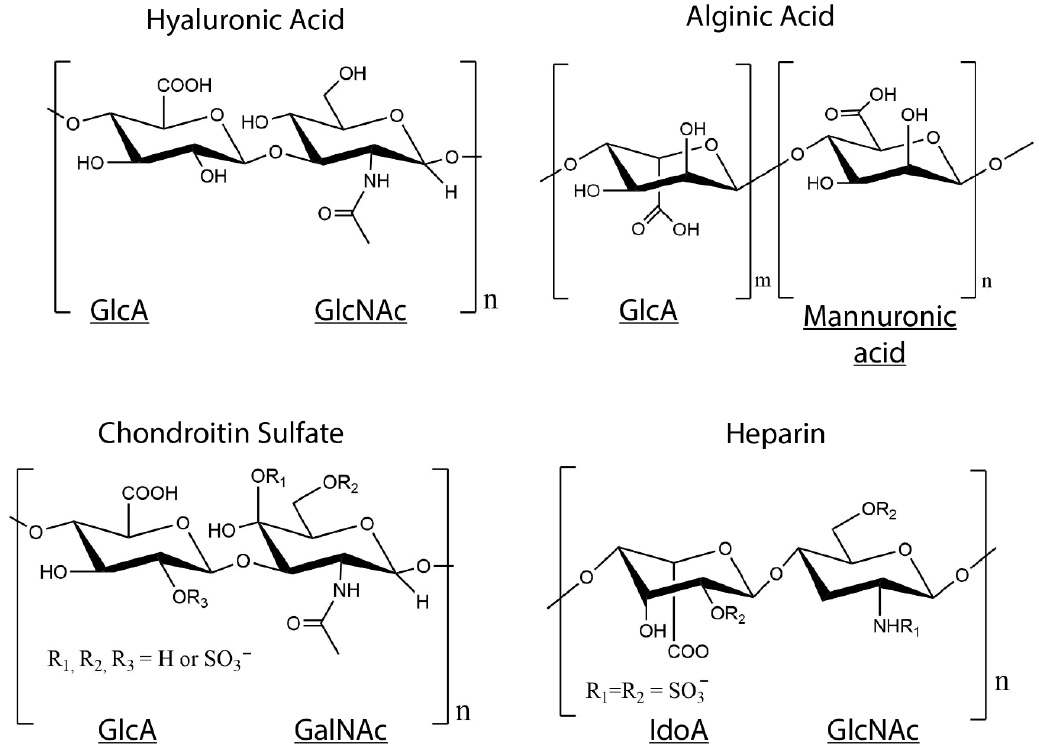
Figure 3. Structures of glycosaminoglycans (GAGs). Disaccharide monomer repeats of glucuronic acid (GlcA) or its epimer iduronic acid (IdoA), and N-acetylgalactosamine (GalNAc) or N-acetylglucosamine (GlcNAc) form the backbone of GAGs, except alginate, which is a GAG analog with GlcA and mannuronic acid repeats. Chondroitin sulfate and heparin are post-translationally sulfated and contain SO 3 − groups on some disaccharide units.